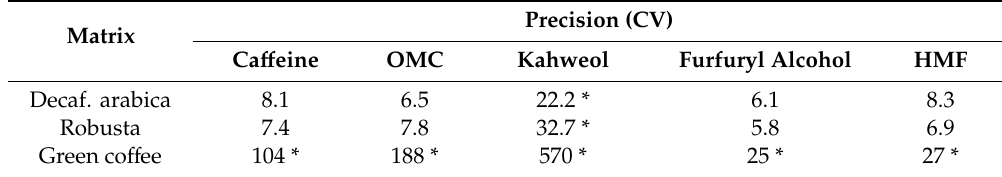
Table 7. Precision of co ff ee constituents.